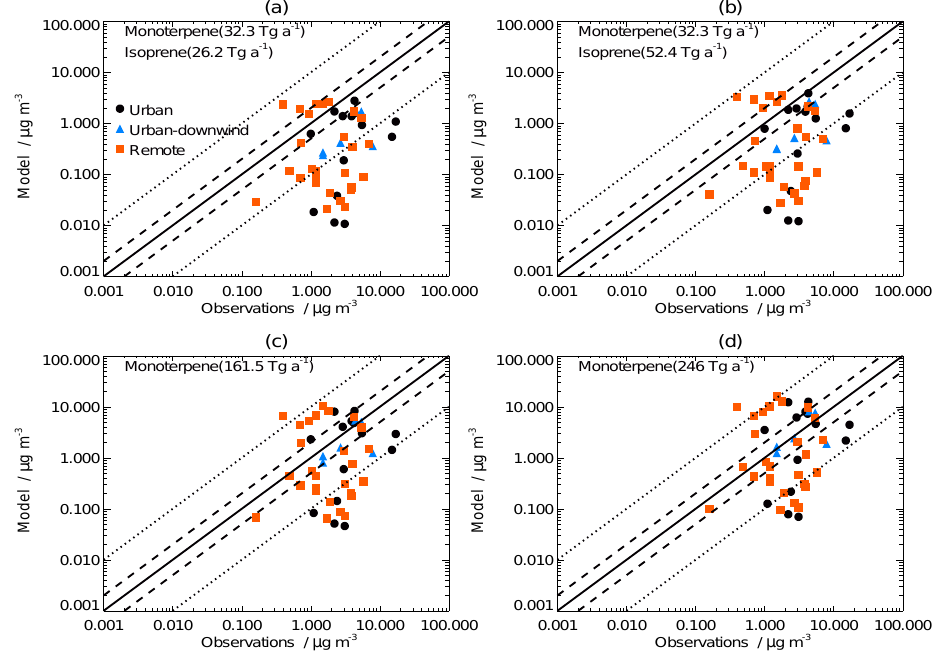
Fig. 3. As for Fig. 2 but for simulated versus observed OOA for (a) simulation 4: monoterpene (32.3Tg(SOA)a − 1 ) , isoprene (26.2Tg(SOA)a − 1 ) ; (b) simulation 5: monoterpene (32.3Tg(SOA)a − 1 ) , isoprene (52.4Tg(SOA)a − 1 ) ; (c) simulation 2: monoterpene (161.5Tg(SOA)a − 1 ) ; (d) simulation 3: monoterpene (246.Tg(SOA)a − 1 ) .